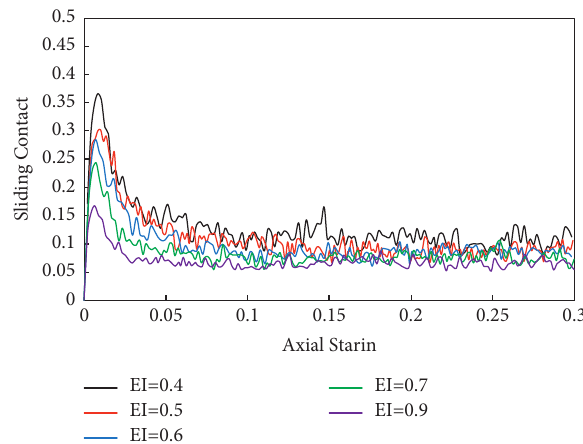
Figure 20: The evolution of the percentage of sliding contact versus axial